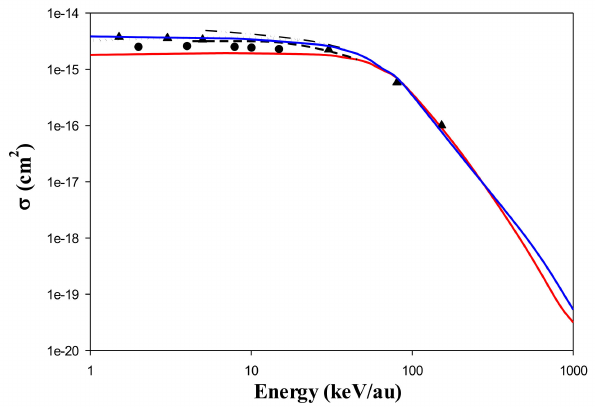
Figure 5. Total cross section for charge exchange in Be 4 + + H(1s) collision, as a function of the impact energy. CTMC (solid red line), QTMC-KW (solid blue line), Reference [22] (dash line), Reference [23] (-..-.. ), Reference [24] ( ... ), Reference [6] ( • ), Reference [4] ( (cid:78) ).